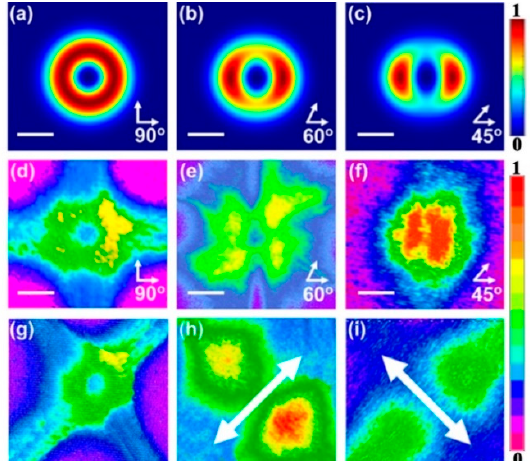
Figure 3. Profiles of the output beam of the DFB polymer laser. ( a – c ) Simulation results of different laser spots. ( d – f ) Images of different laser spots. Angles formed by white arrows represent the direction of the substructure in the 2D cavity. The scale bar is 0.3 μ m. ( g ) Three-dimensional energy distribution of the lasing spot. ( h , i ) Laser spots measured through a linear polarizer. The double-head arrow indicates the direction of the polarizer.